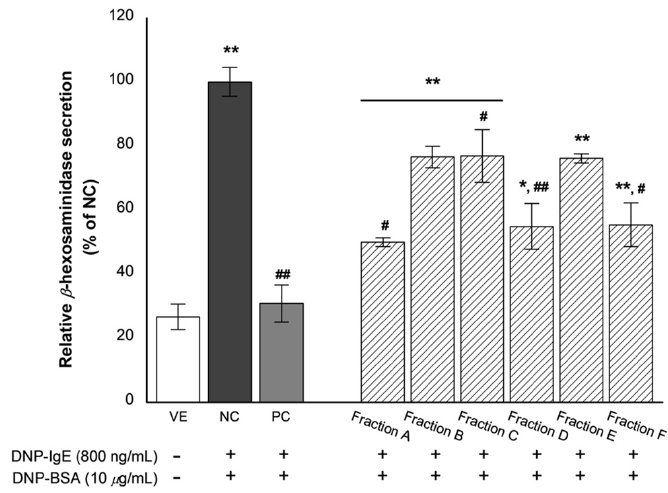
Figure 4. Inhibitory effect of the six oil fractions on β ‐ hexosaminidase release. VE: vehicle, DMSO; NC: negative control, 800 ng/mL DNP ‐ IgE and 10 ‐μ g/mL DNP ‐ BSA treated group; PC: positive